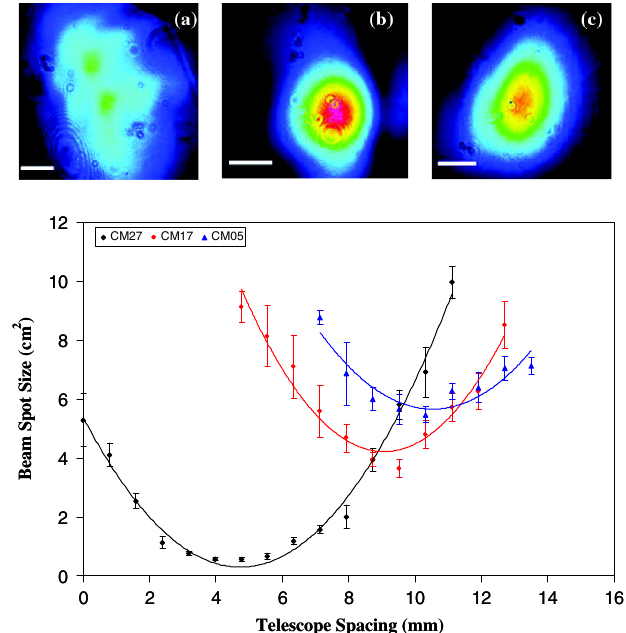
FIG. 2. Laser beam spot sizes measured at three locations of the SCL as a function of the telescope spacing (distance between focusing and defocusing lenses). Inset boxes a, b, and c: images of the laser beam spot measured at cryomodule (CM) 27, 17, and 5, respectively. All scale bars in inset boxes correspond to 1 Fig. 2 as a function of the telescope spacing. The telescope spacing (distance between focusing and defocusing lenses) is variable from 0 to 16 mm and is currently set at (cid:2) 10 mm